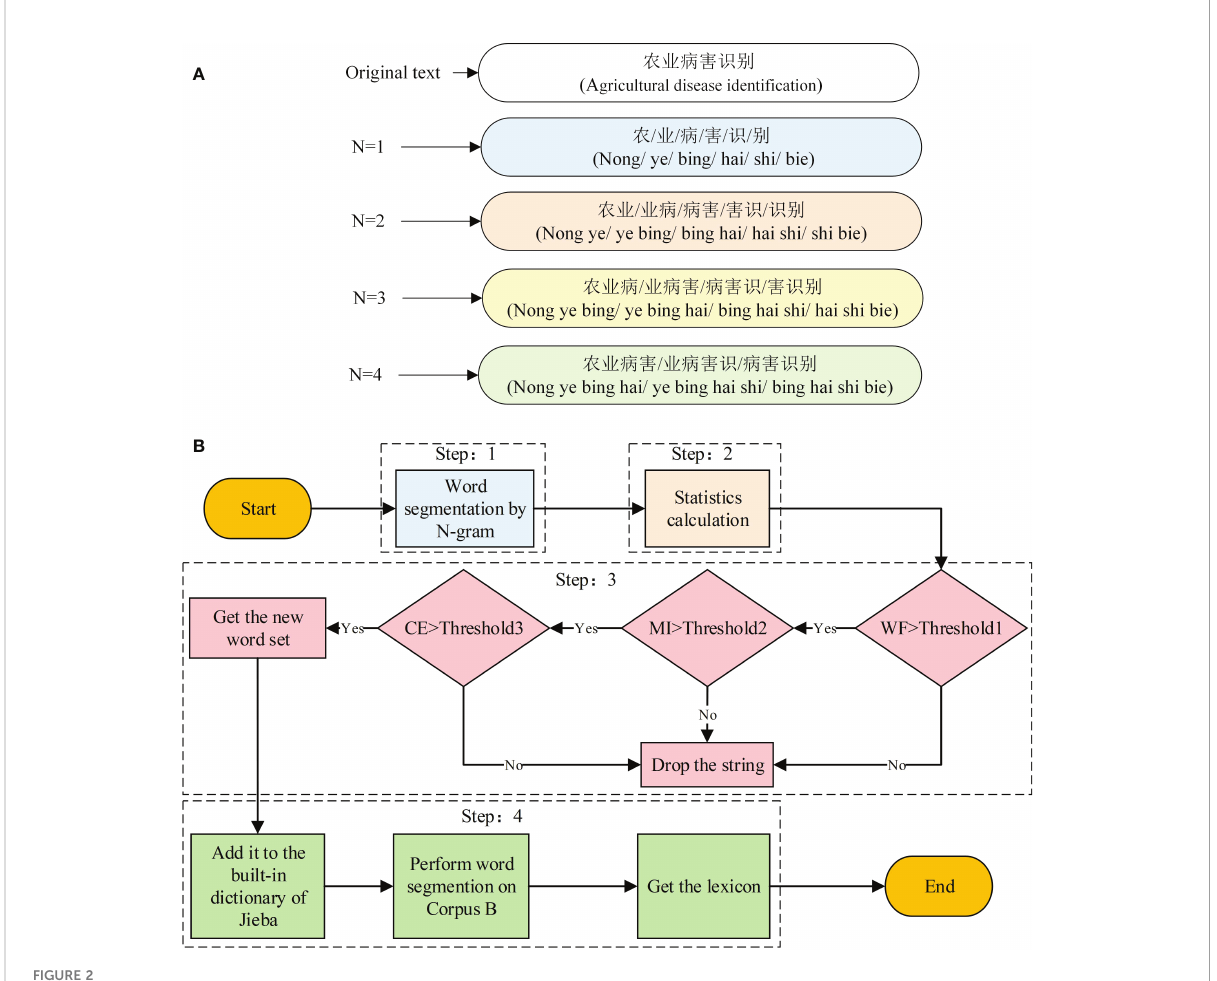
FIGURE 2 (A, B) Lexicon construction